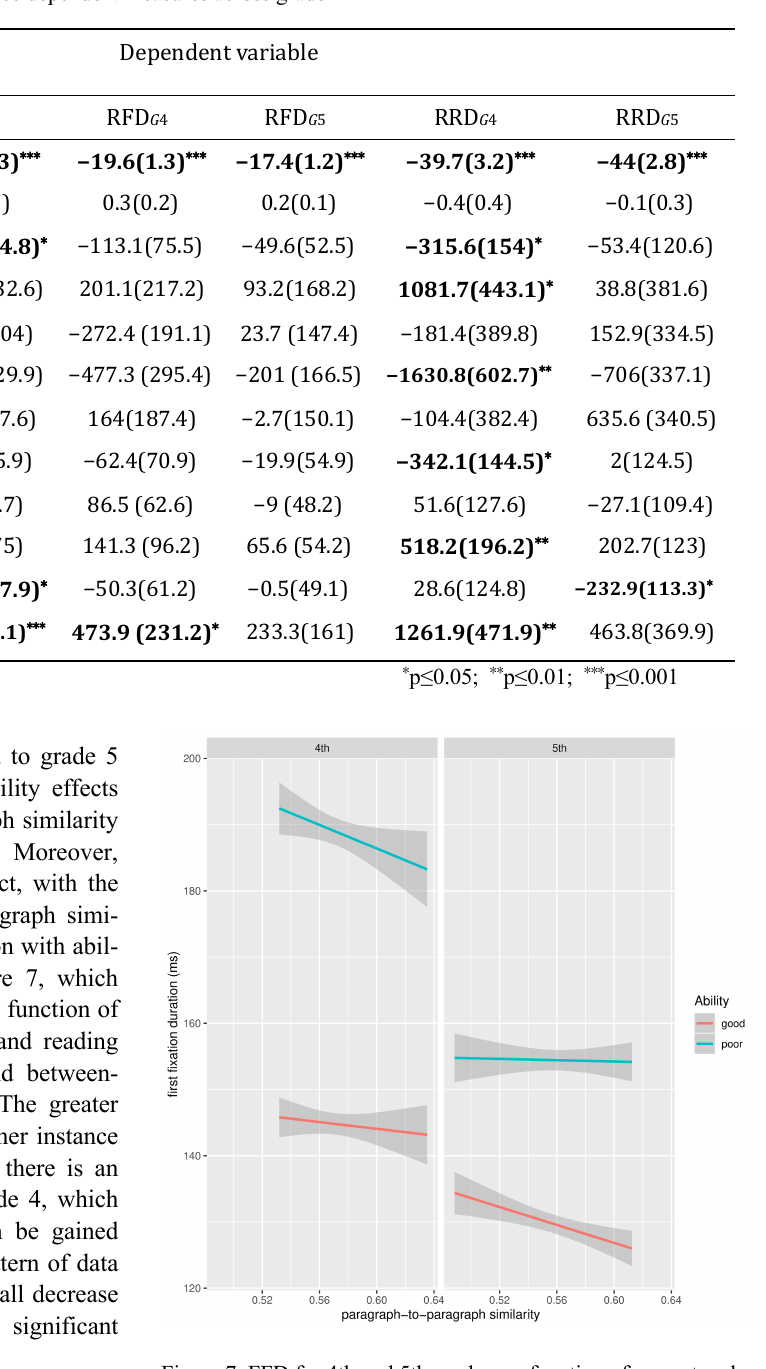
Figure 7. FFD for 4th and 5th grade as a function of current and preceding paragraph similarity and reading ability: random effects removed